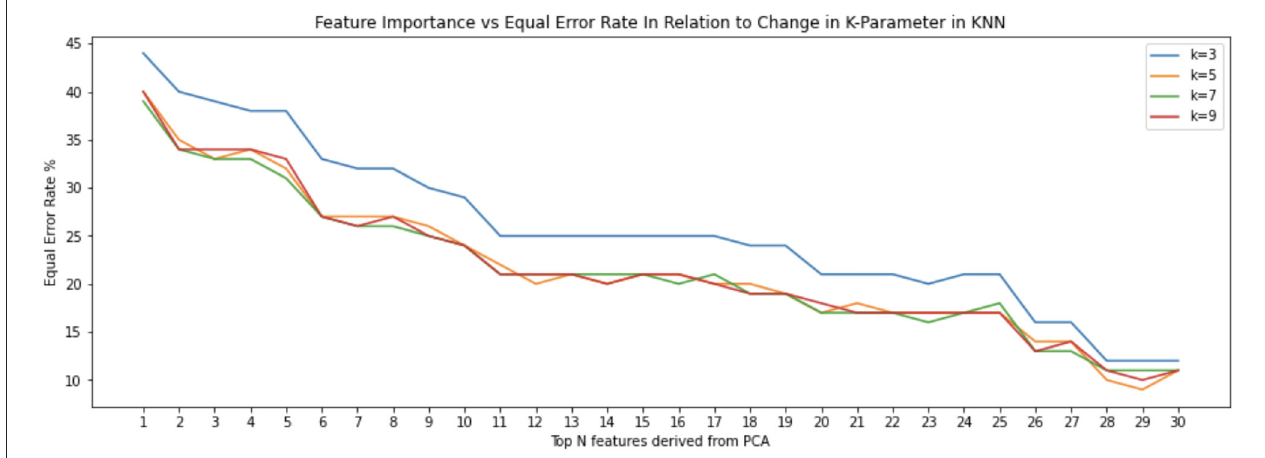
FIGURE 8 | Classification done using all 30 features defined by Frank et al. (2013), derived from the first principal component result in stabilization of equal error rate. These features are numbered according their order of importance: “average velocity,” “50%-perc. pairwise velocity,” “median velocity at last 3 pts,” “80%-perc. pairwise velocity,” “20%-perc. pairwise velocity,” “direction of end-to-end line,” “average direction,” “80%-perc. pairwise acc,” “stroke duration,” “direct end-to-end distance,” “stop $y$,” “20%-perc. pairwise acc,” “ratio end-to-end dist and length of trajectory,” “median acceleration at first 5 points,” “50%-perc. pairwise acc,” “length of trajectory,” “largest deviation from end-to-end line,” “phone orientation,” “80%-perc. dev. from end-to-end line,” “stop $x$,” “50%-perc. dev. from end-to-end line,” “20%-perc. dev. from end-to-end line,” “start $y$,” “mid-stroke finger orientation,” “up/down/left/right flag,” “mid-stroke area covered,” “mean resultant length,” “mid-stroke pressure,” “start $x$,” and “inter-stroke time.”